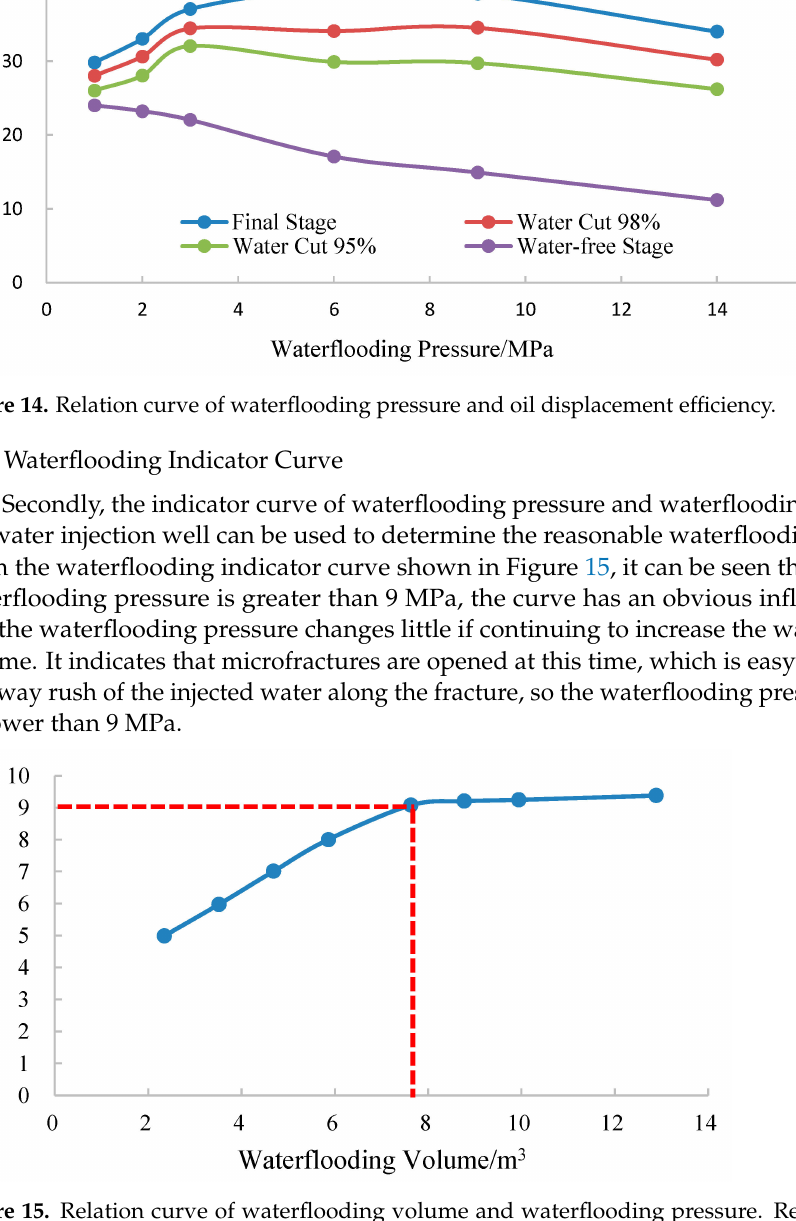
Figure 15. Relation curve of waterflooding volume and waterflooding pressure. Red dotted line means the value of waterflooding pressure is